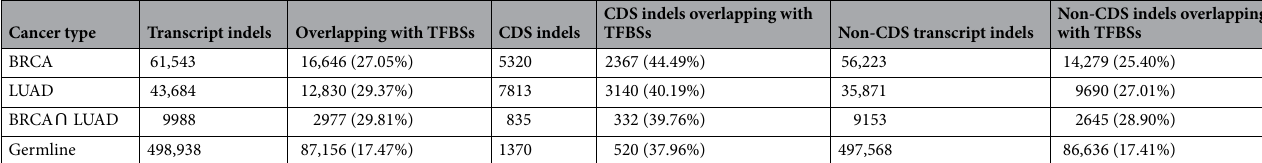
Table 4. Somatic transcript indels overlapping with TFBSs.